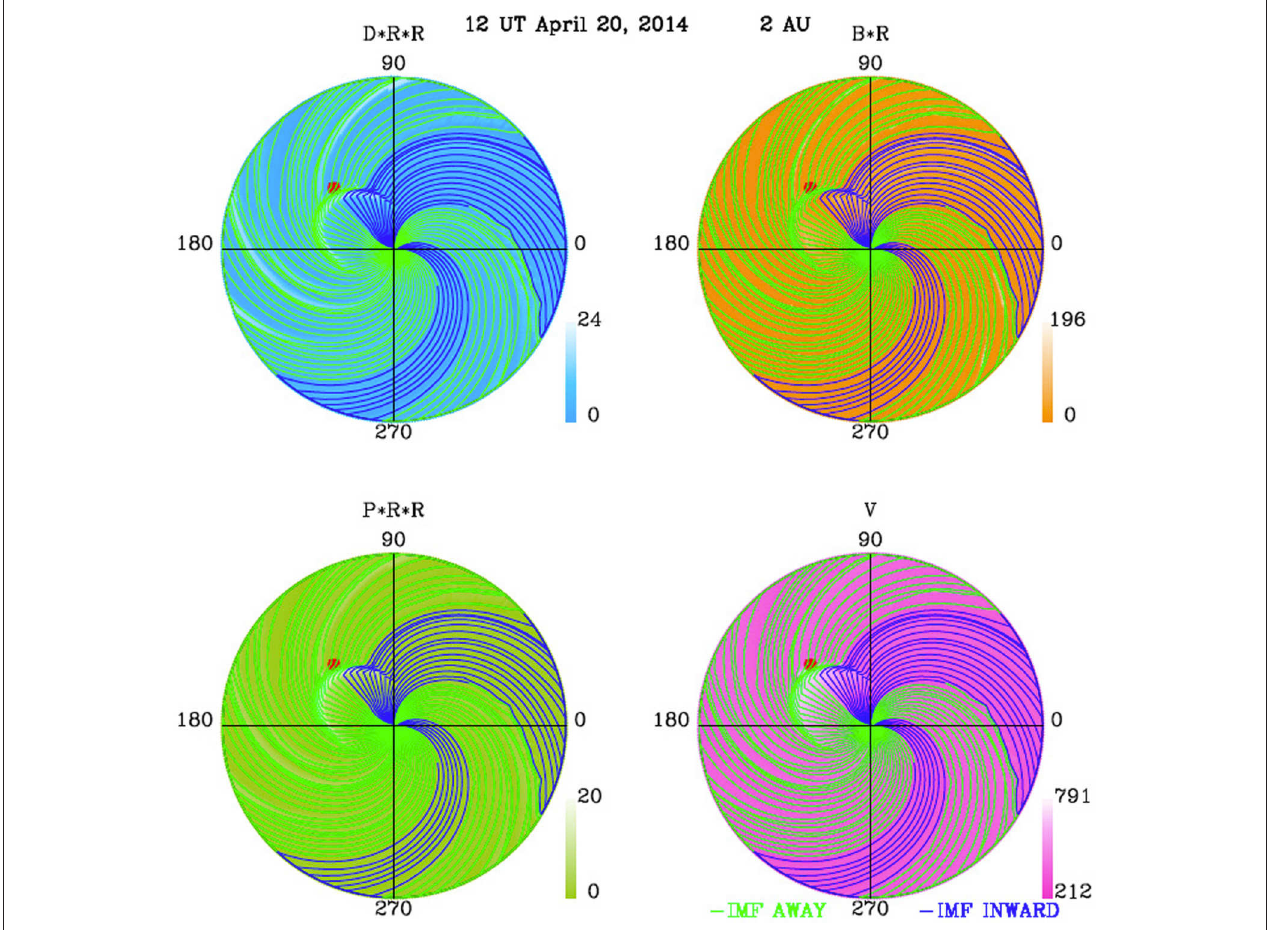
FIGURE 3 | A snapshot of the cone plus HAF simulation on the solar wind and CME in the ecliptic plane on April 18, 2014. The panels from left to right and from top to bottom are proton density, magnetic field strength, dynamic pressure, and solar wind speed, respectively. The red dot represents the Earth. The inward and outward field lines are indicated by blue and green lines. This Figure is adapted from Wang et al.